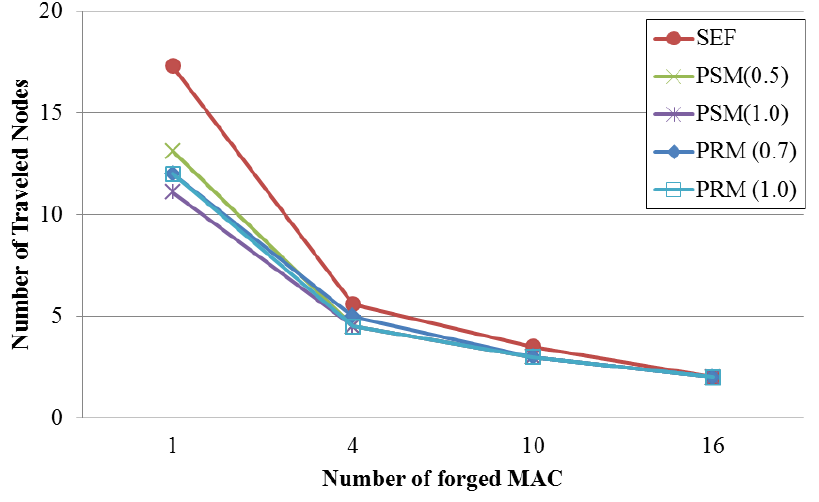
Figure 4. Average number of traveled nodes for filtering false reports with the security value